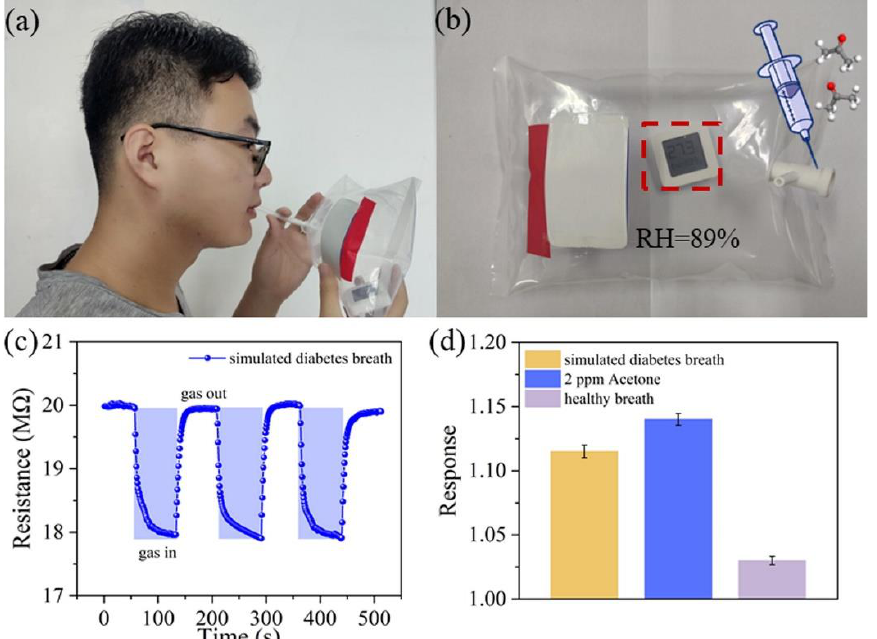
Figure 11. ( a , b ) The process of obtaining the simulated exhaled gas of diabetic patients. ( c ) A sche- matic diagram depicts how the simulated exhaled gas of diabetic patients is tested [46].